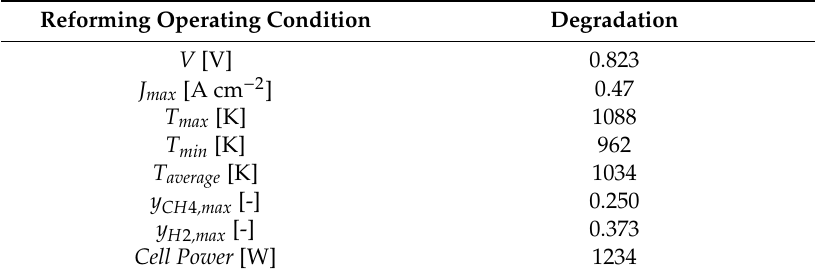
Table 6. Main results of the simulation using a local map of σ to describe catalyst deactivation.